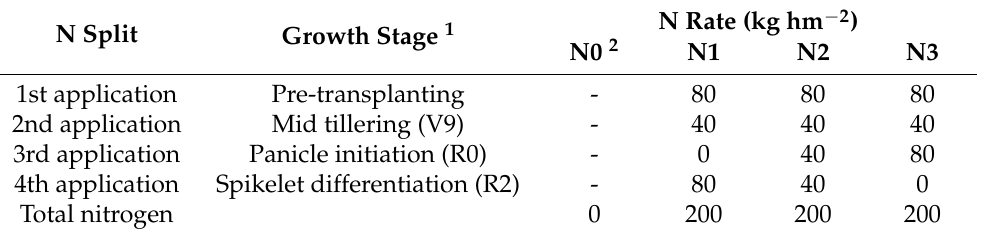
Table 2. The amount of N applied to four treatments at different growth stages in the experiment. N